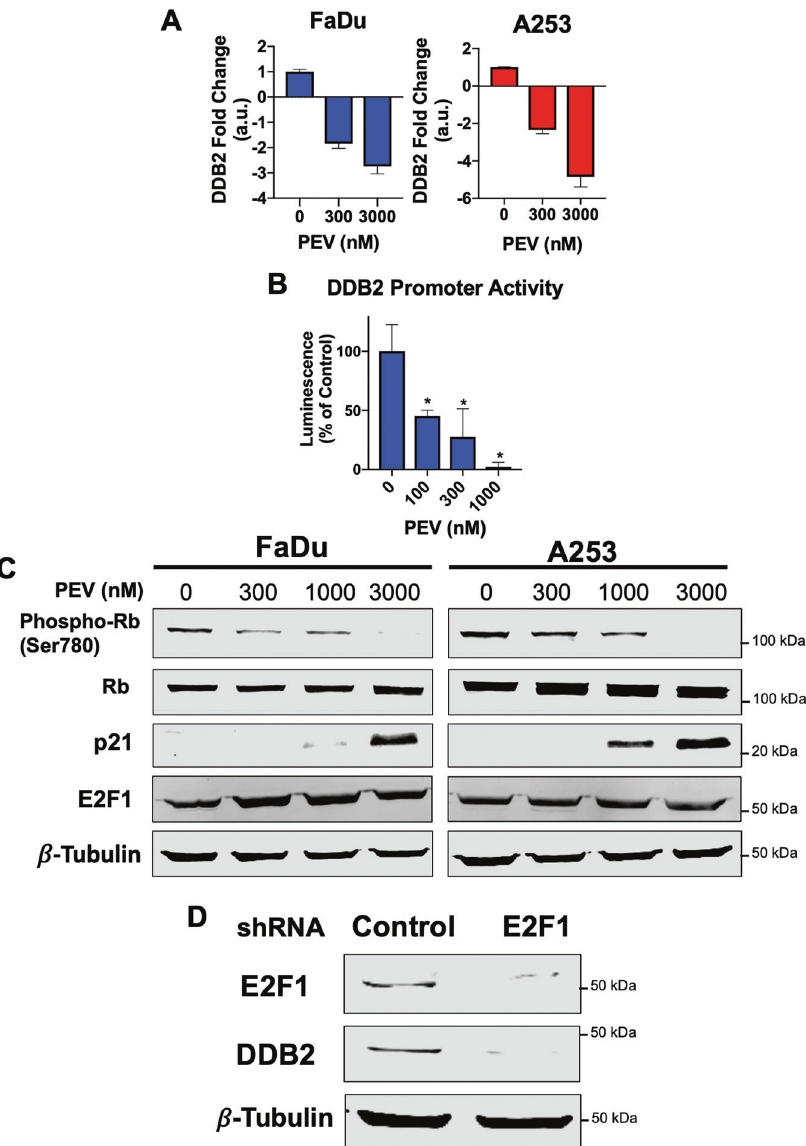
quantify changes in DDB2 expression. Mean ± SD, n = 3. B Pevonedistat decreases DDB2 promoter activity. FaDu cells were transfected with lentiviral particles containing a DDB2 promoter fl anking a luciferase gene. Cells stably expressing this construct were treated with the indicated concentrations of pevonedistat for 24 h and DDB2 promoter activity was quanti fi ed. Mean ± SD, n = 3. *Indicates a signi fi cant difference from control, p < 0.05. C Pevonedistat increases p21 expression, which is associated with a reduction in Rb phosphorylation. FaDu and A253 cells were treated with the indicated concentrations of pevonedistat for 24 h. Phospho-Rb, total Rb, E2F1, and p21 levels were determined by immunoblotting. D E2F1 knockdown results in decreased DDB2 expression. E2F1 was silenced by lentiviral shRNA. The expression levels of E2F1 and DDB2 were measured by